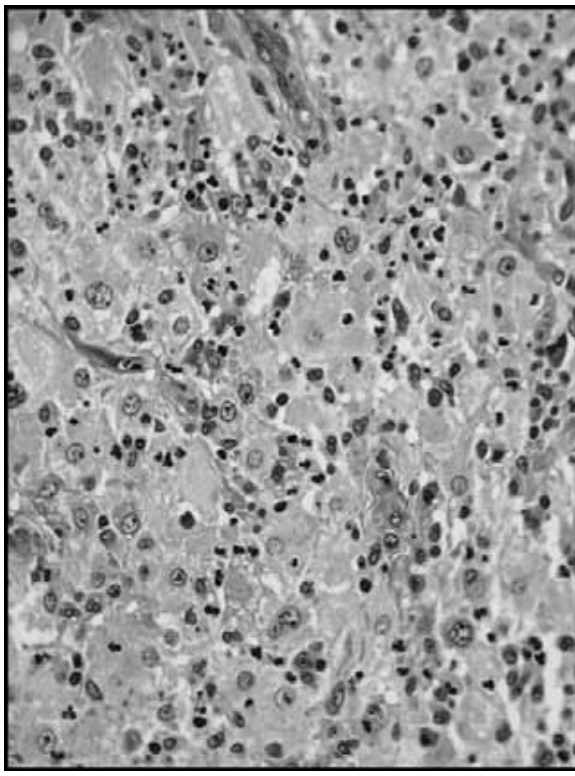
Figura 3 – Hematoxilina e eosina 200×: esses histiócitos contêm no citoplasma células inflamatórias íntegras (emperipolese)